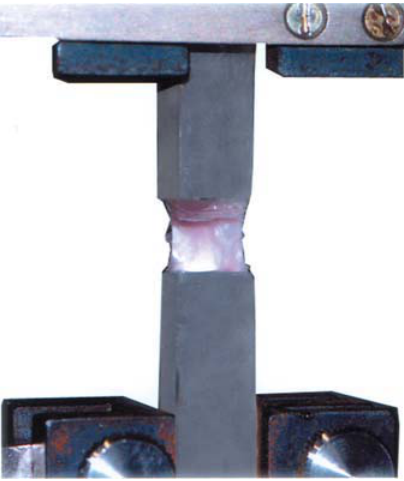
FIGURE 5- Specimen during tensile bond strength testing